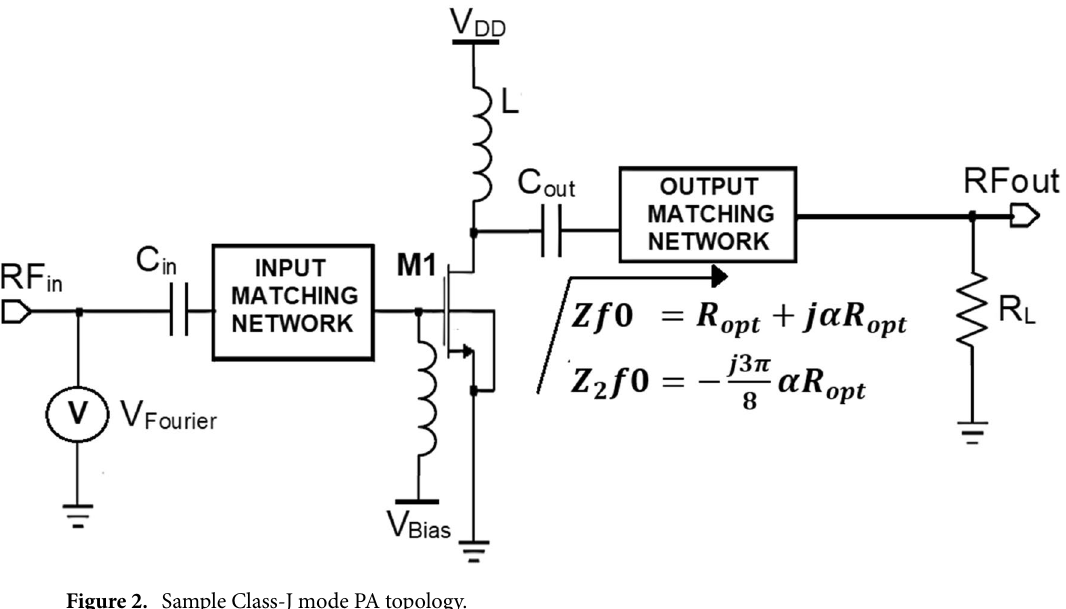
Figure 2. Sample Class-J mode PA